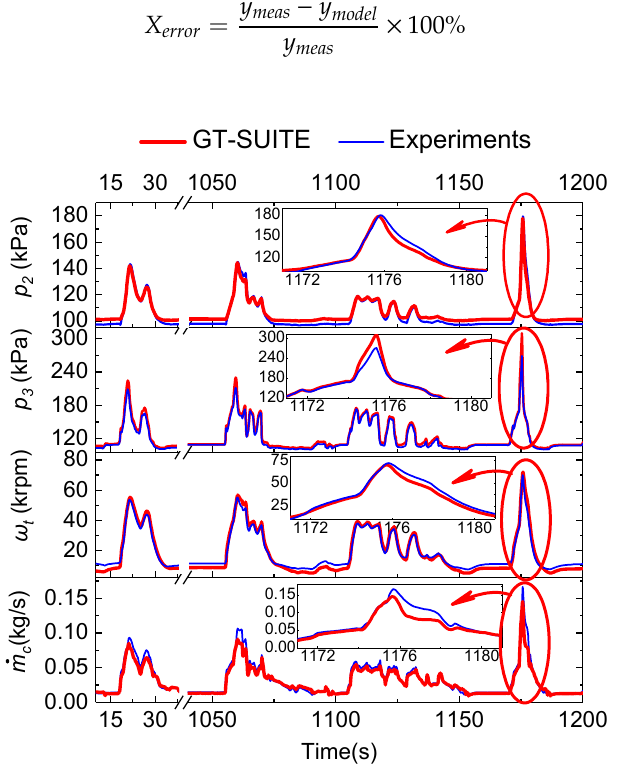
Figure 4. Validation of the GT-SUITE model over a segment of the hot start FTP-75 drive cycle in terms of boost pressure, pre-turbine pressure, and compressor mass flow rate [27]. Table 4. Estimation error of the GT-SUITE